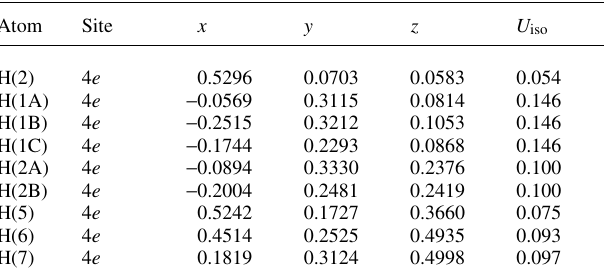
Table 2. Atomic coordinates and displacement parameters (in Å 2 )